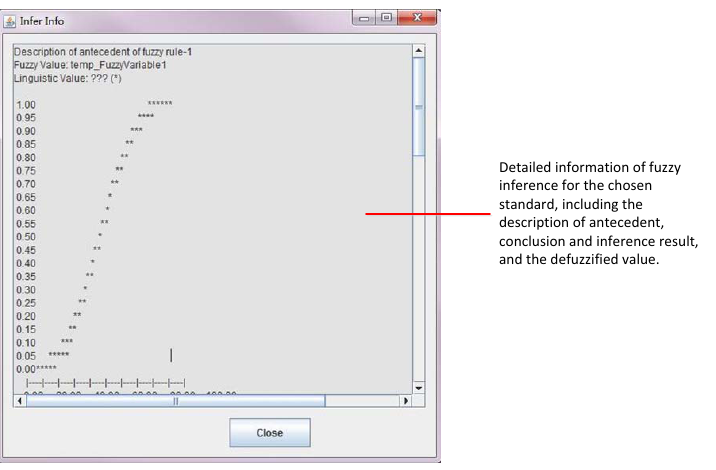
Detailed information of fuzzy inference for the chosen